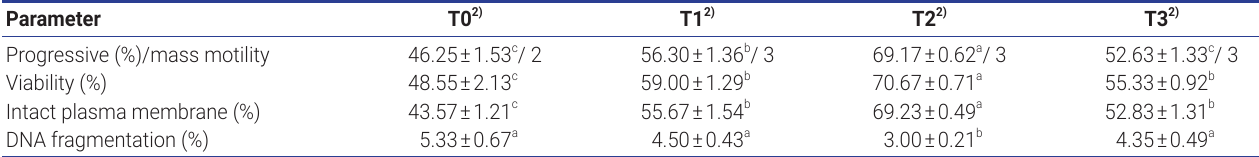
Table 2. The quality of post-thawed Simmental bull semen diluted in SM-EY extender, with the addition of various doses of GTE (mean±SE) (n = 6 replication respectively 1) ) Parameter